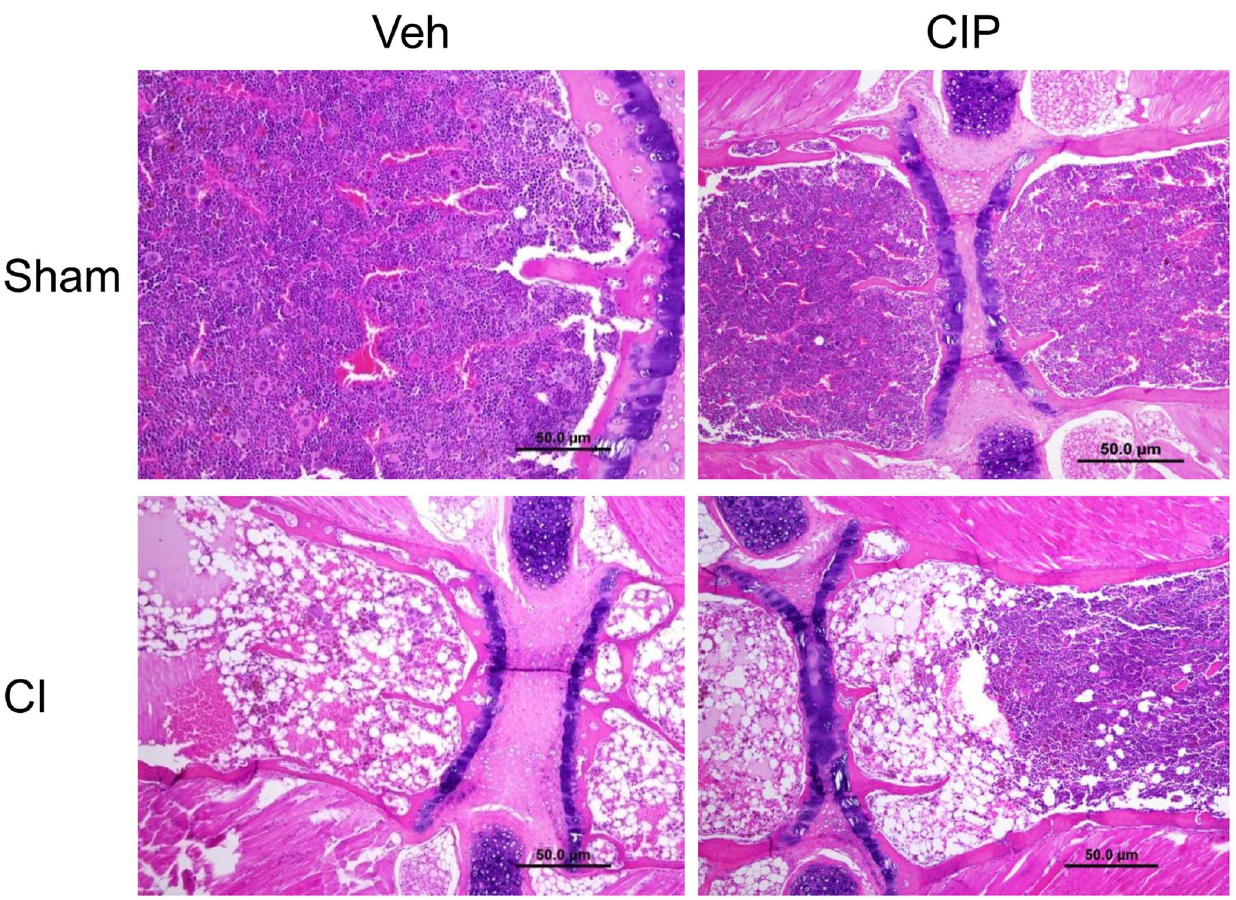
Figure 4. CIP accelerated bone marrow recovery after CI. On day 10 after CI, femurs were collected from surviving mice and prepared for hematoxylin-eosin staining on paraffin sections. Representative histopathology photos are shown. n=4 2 5 per group. CI: combined injury; CIP: ciprofloxacin; Veh: vehicle.